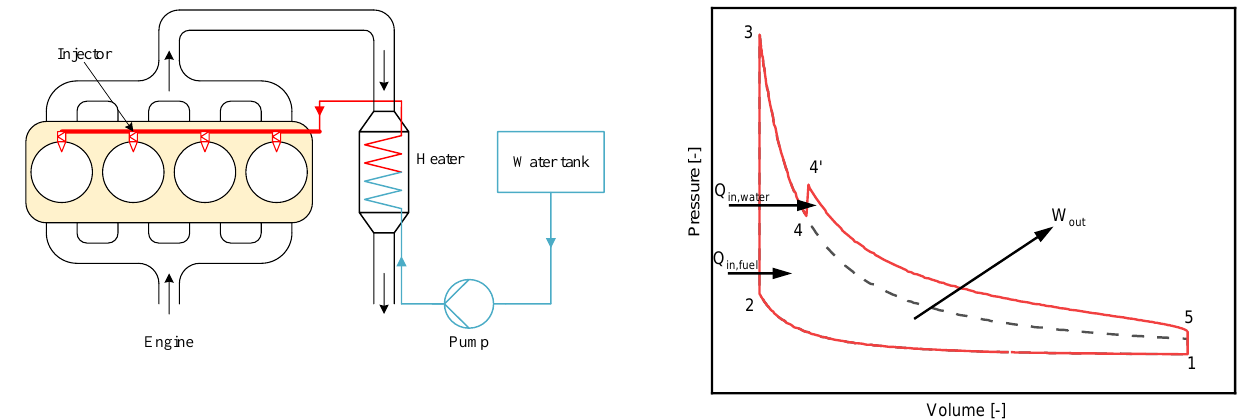
Figure 1. Schematic and P-V curve of the in-cylinder steam-assisted cycle.